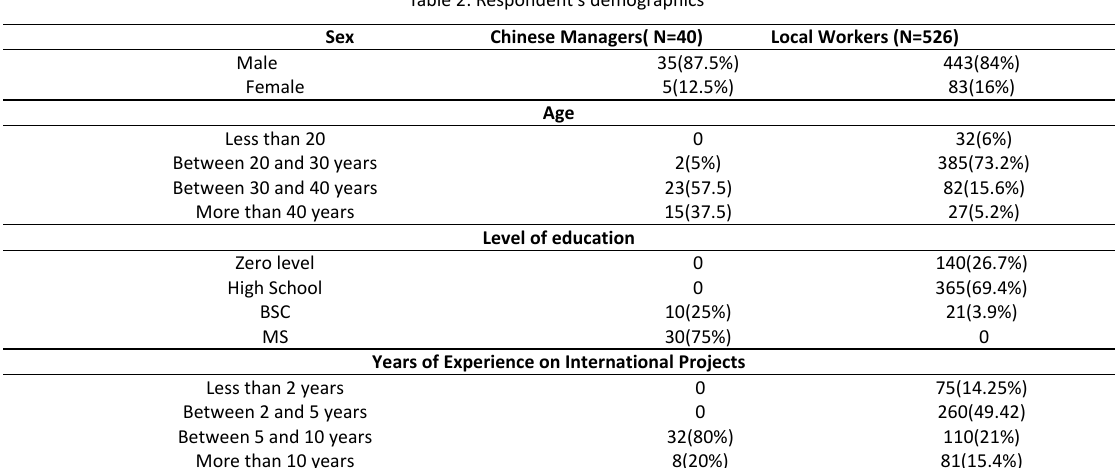
Table 2: Respondent’s demographics